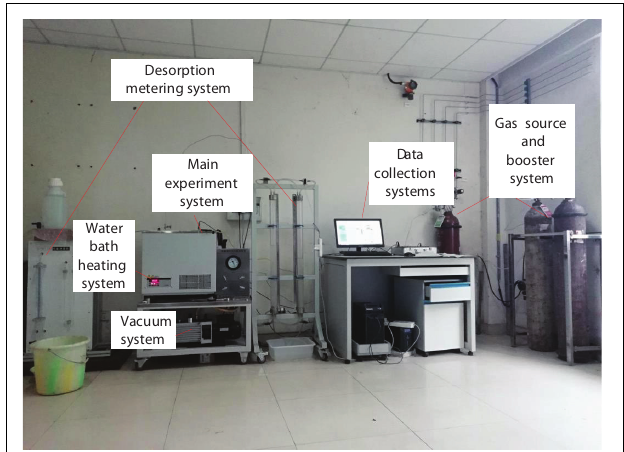
FIGURE 5 | Physical diagram of simulation experiment system of rock gas escape loss.